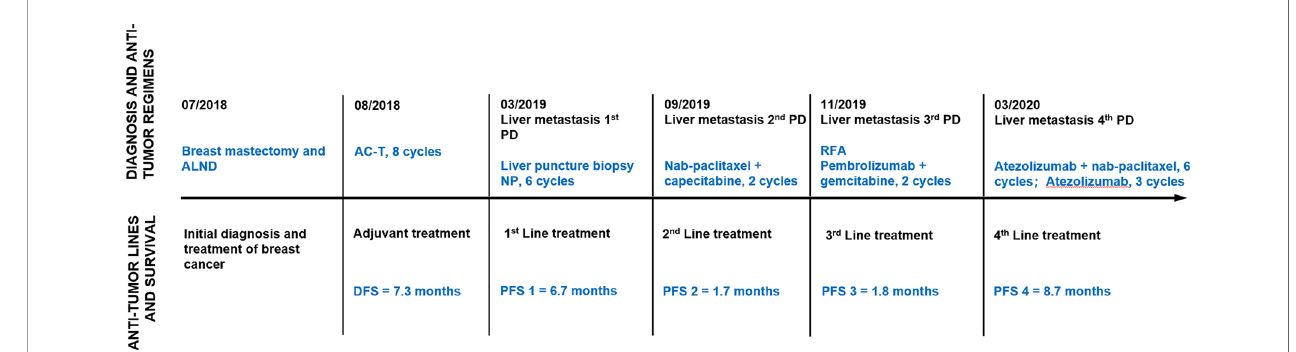
FIGURE 1 | Timeline of antitumor regimens and outcomes. Line graph illustrating disease progression, antitumor lines, regimens, and outcomes from July 2018 to November 2020. ALND, axillary lymph node dissection; AC-T, doxorubicin, cyclophosphamide followed by paclitaxel; PD, progressive disease; NP, vinorelbine plus carboplatin; RFA, radiofrequency ablation; DFS, disease-free survival; PFS, progression-free survival.